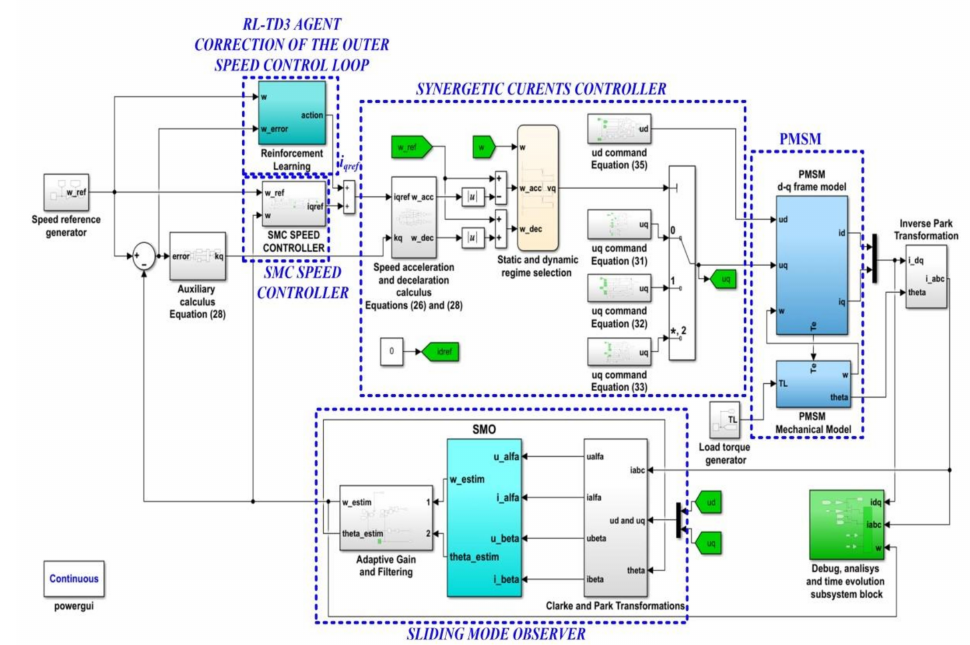
Figure 22. Block diagram of the MATLAB/Simulink implementation for the PMSM control based on SMC and synergetic controllers using the RL-TD3 agent for the correction of i qref .